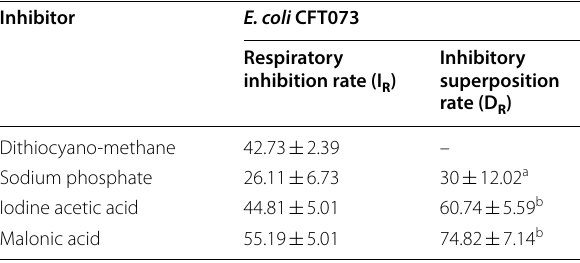
Different letters indicate significant differences among different superpositions ( P <